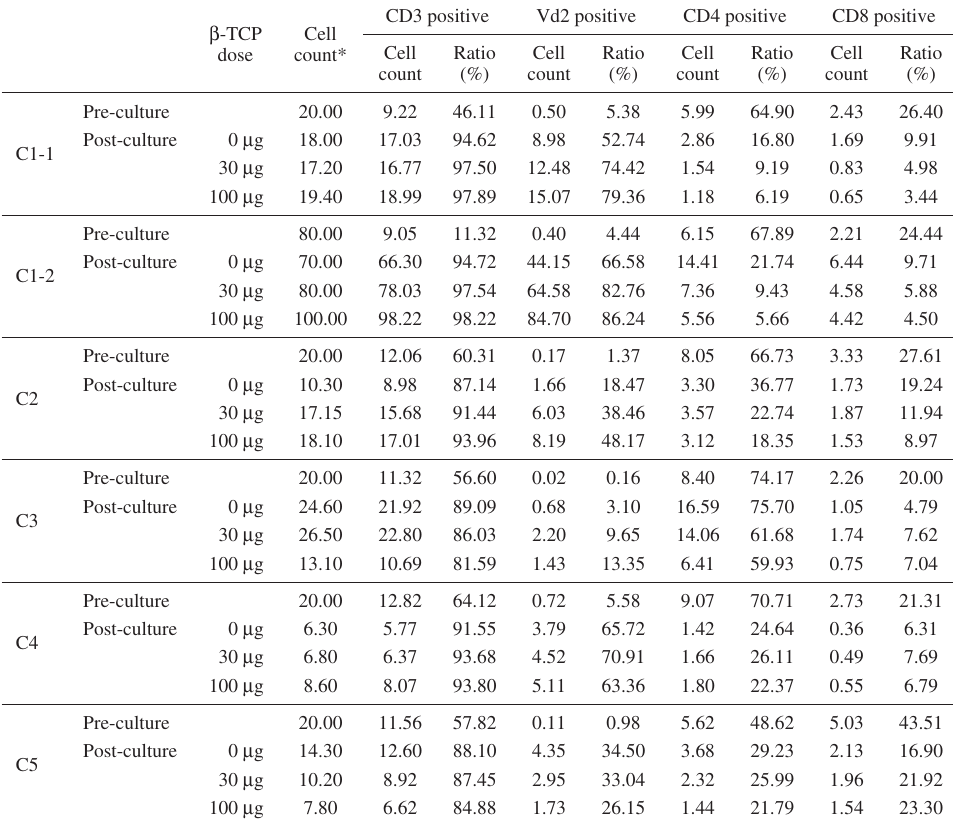
Table 1. Analysis